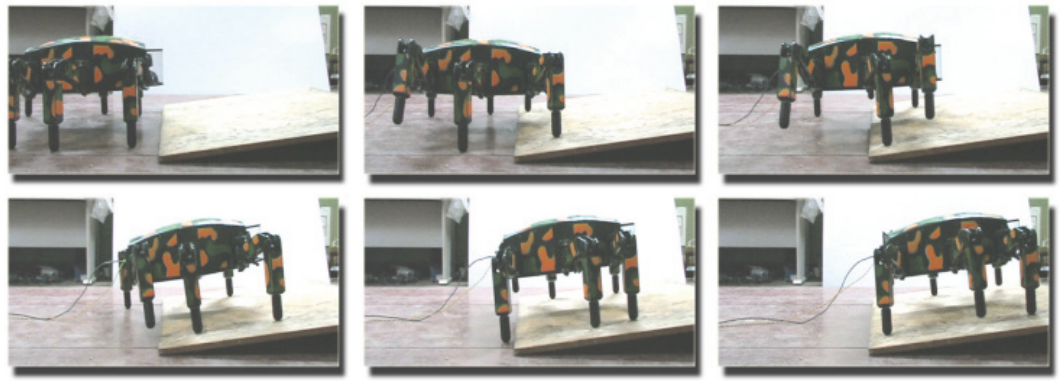
Figure 20: The screenshot of the